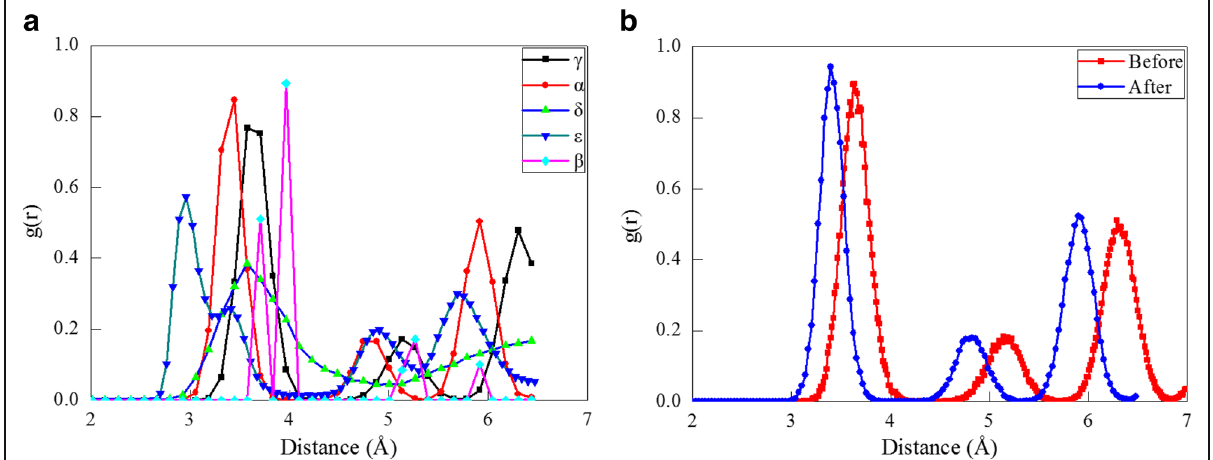
Fig. 2 RDF analysis of cerium phases; (color online) a RDF of cerium phases. b RDF before and after the compression of the γ -Ce